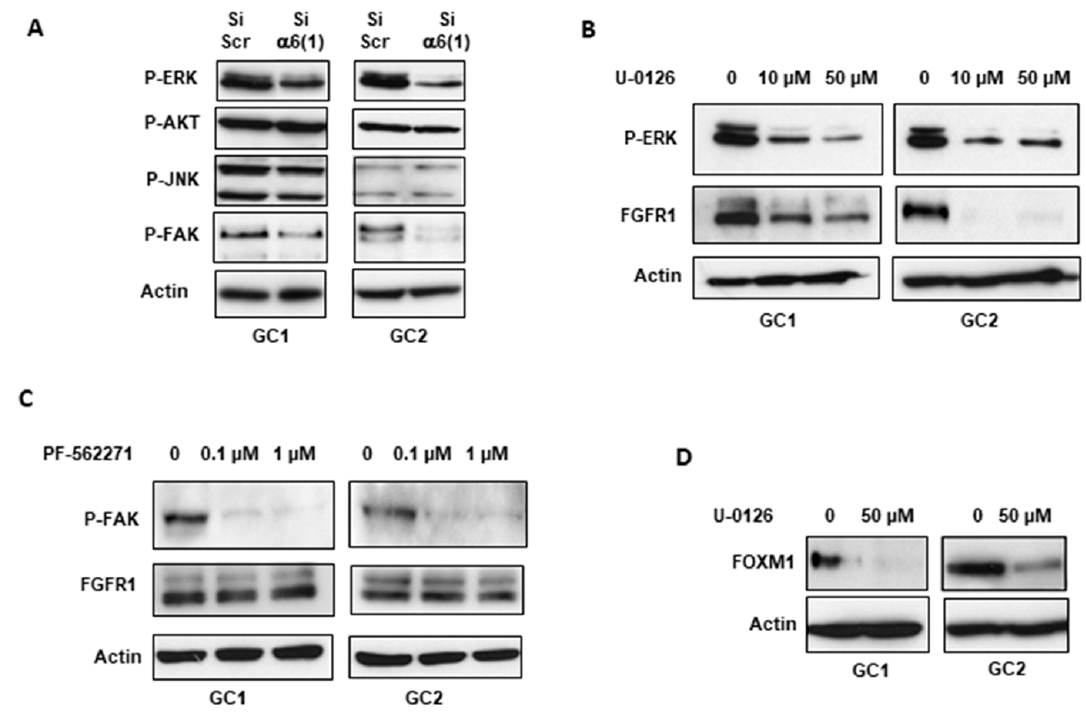
Figure 3. FGFR1 and its downstream target, FOXM1, are regulated via the ERK pathway. ( A ) GBMSC derived from GBM biopsy specimens (GC1, GC2) were transfected with an α 6-integrin siRNA (si- α 6 (1)) or a scramble control (si-Scr). Activation of the different signaling pathways, ERKs, AKT, JNK or FAK were analyzed with Western blot using phospho-specific antibodies. ( B – D ) GBMSC were pretreated or not with 10–50 µ M of the ERK inhibitor U-0126 or with 0.1–1 µ M of the FAK inhibitor PF-562271 for 24 h. The phosphorylation of ERKs or FAK, as well as the expression of FGFR1, were analyzed using Western blot. Images are representative of 3 independent experiments. Actin was used as a loading control.